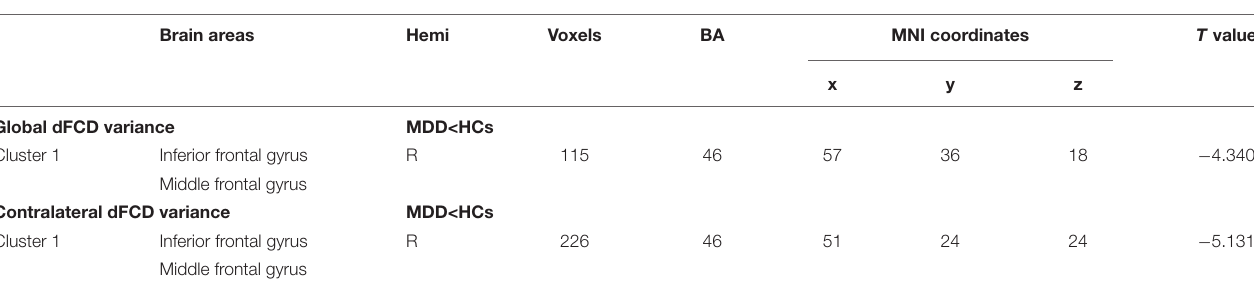
FIGURE 1 | The group difference for (A) global and (B) contralateral dFCD variance between the MDD and HCs groups. The color bars indicate the T value based on two-sample t -test. The statistical significance level was set at P voxel < 0.005, P cluster < 0.05 under Gaussian random field theory (GRF) corrected. The histogram shows the average (C) global and (D) contralateral dFCD variance in the IFG/MFG. * p < 0.05. These results are mean ± standard error. Abbreviations: dFCD, dynamic functional connectivity density; IFG, inferior frontal gyrus; MFG, middle frontal gyrus; MDD, major depressive disorder; HCs, healthy controls; L, left; R, right. TABLE 2 | Altered global and contralateral dFCD variance in MDD